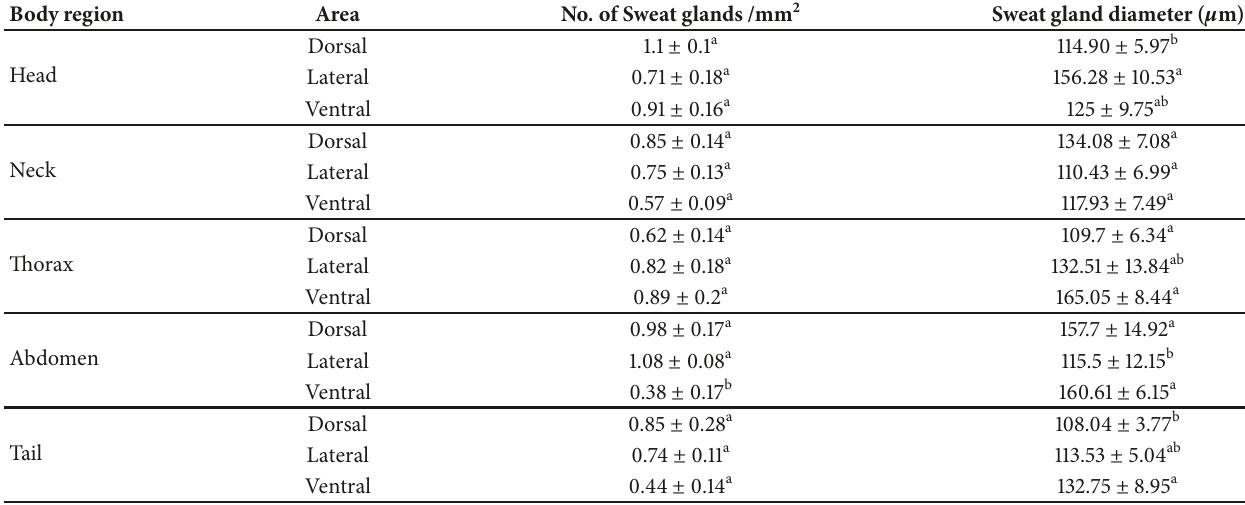
Table 1: Number of sweat glands/mm 2 and diameter of sweat glands in different body areas of different regions. Body